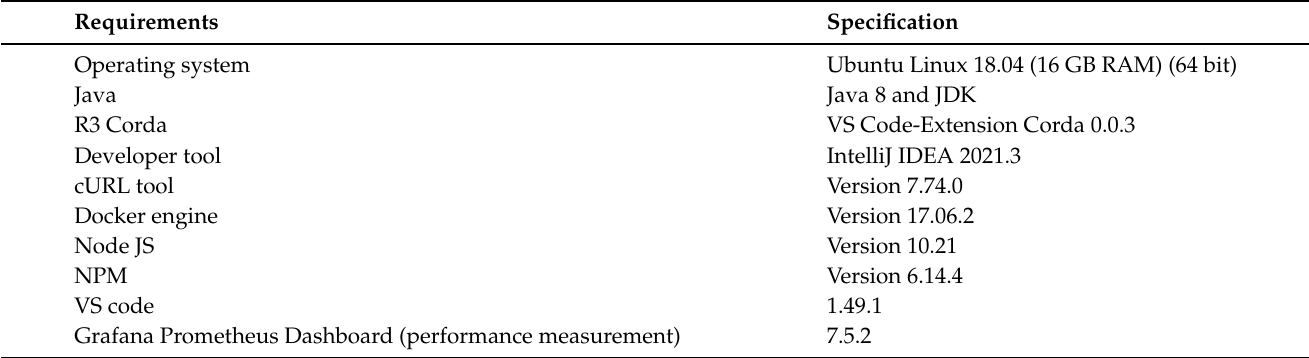
Table 2. Software requirements and specifications for proposed Corda blockchain